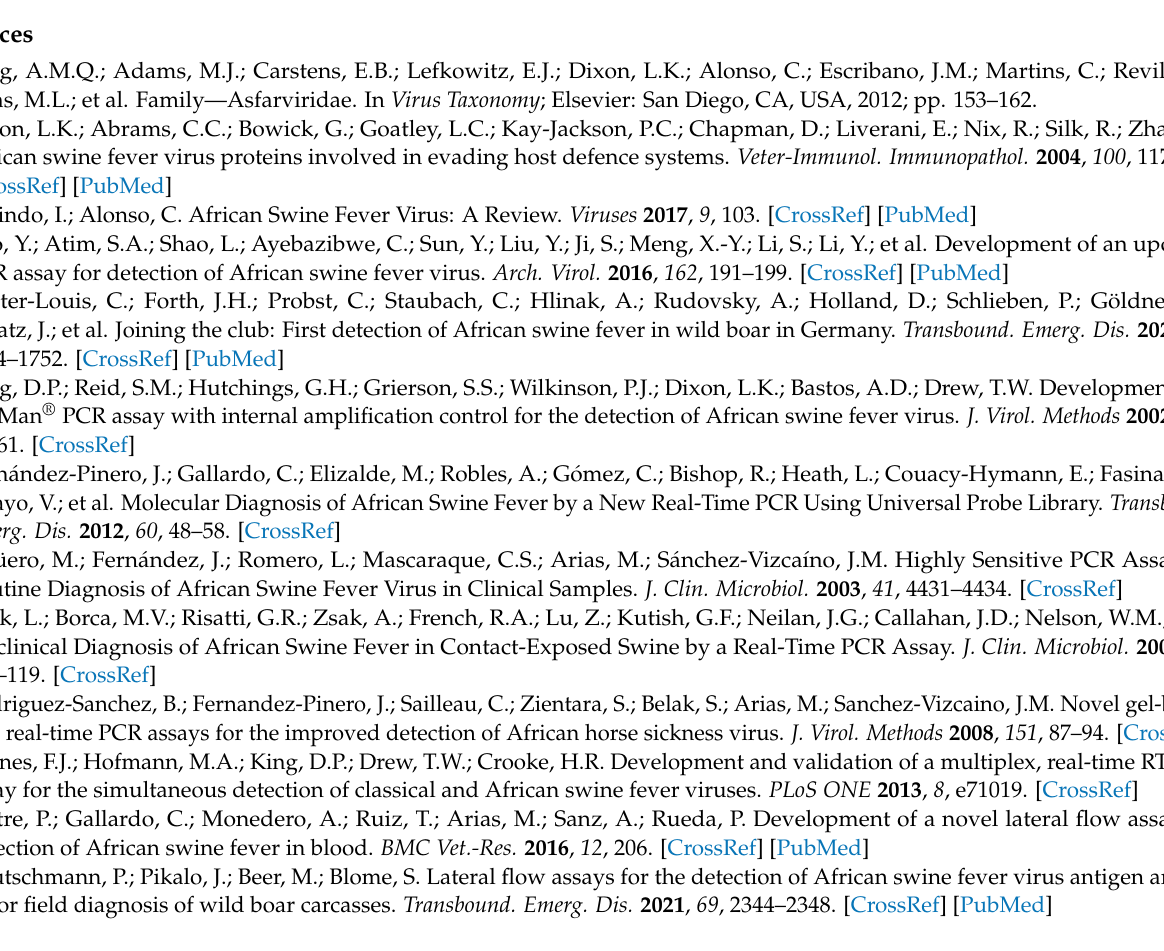
Table S2: Summary of all Ct values as a comparison between the extraction/releasing methods applied on the different portable real-time PCR detection